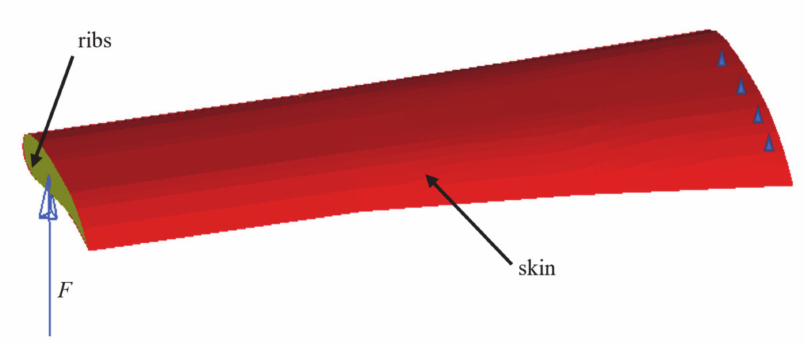
Figure 8. A wing